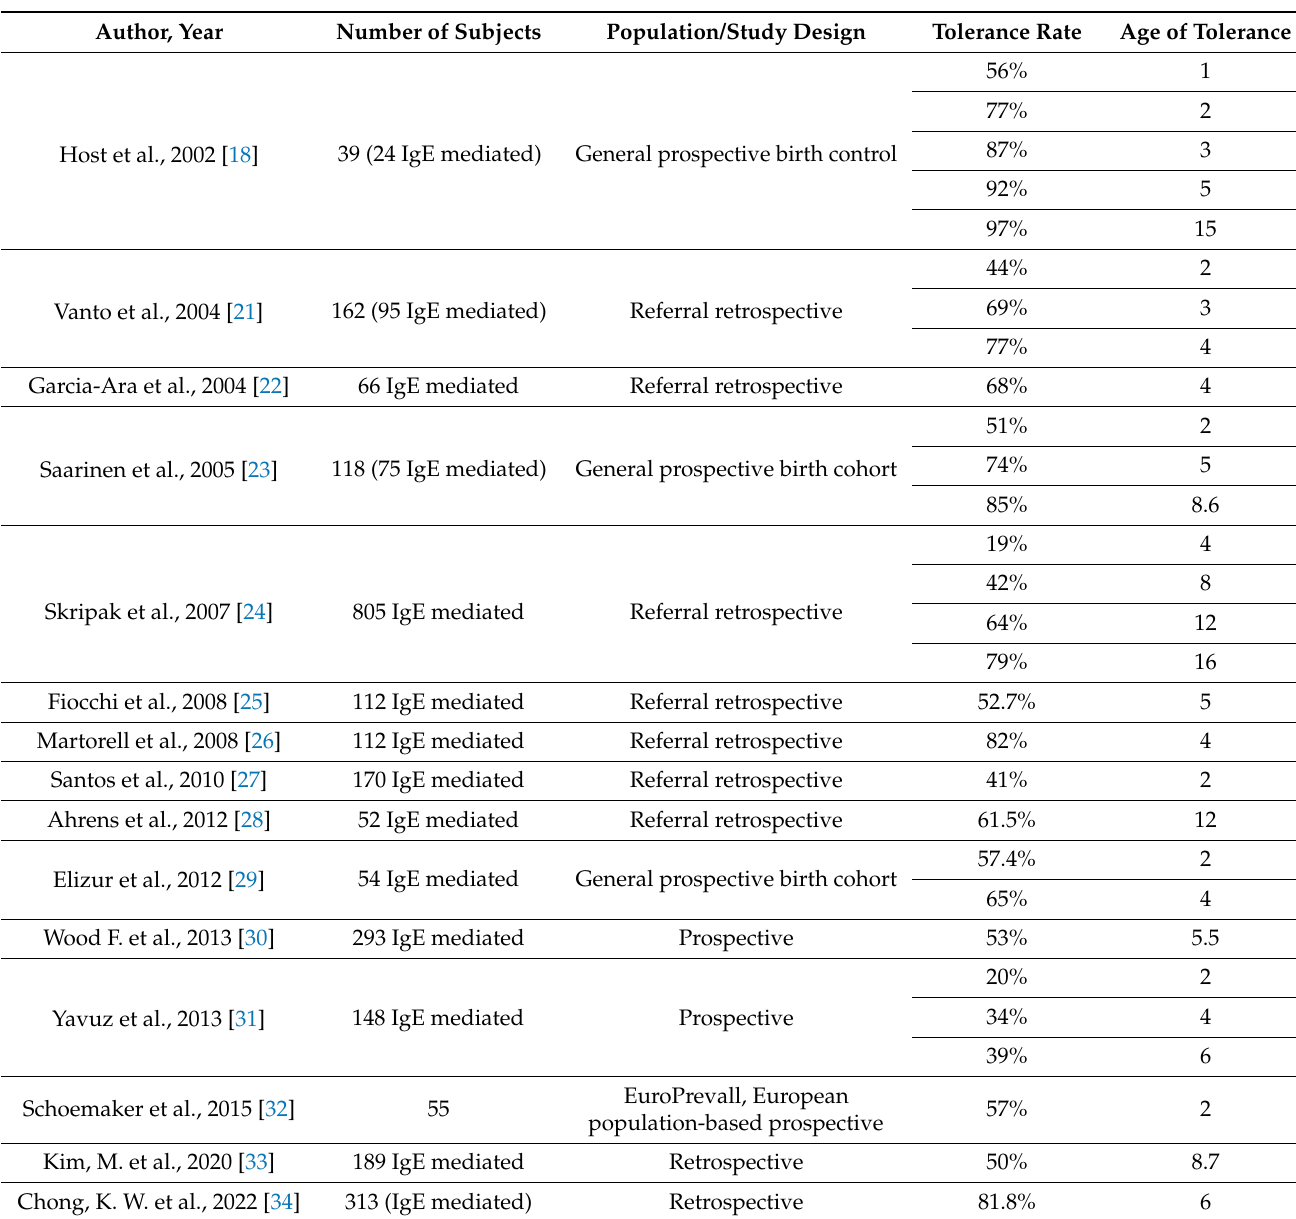
Table 1. Natural history of CMA in different populations and settings (adapted and updated